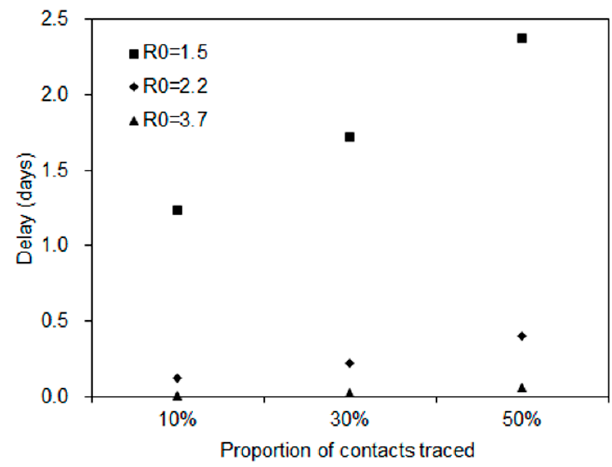
Figure 4. Delay in the time to a major epidemic gained by travel volume reduction. The median delay is shown for Japan, using relative reduction in the probability of a major epidemic. The vertical axis represents the time delay to a major epidemic (in days), and the horizontal axis represents the proportion of contacts traced. Each shaped dot represents different values of the basic reproduction number.